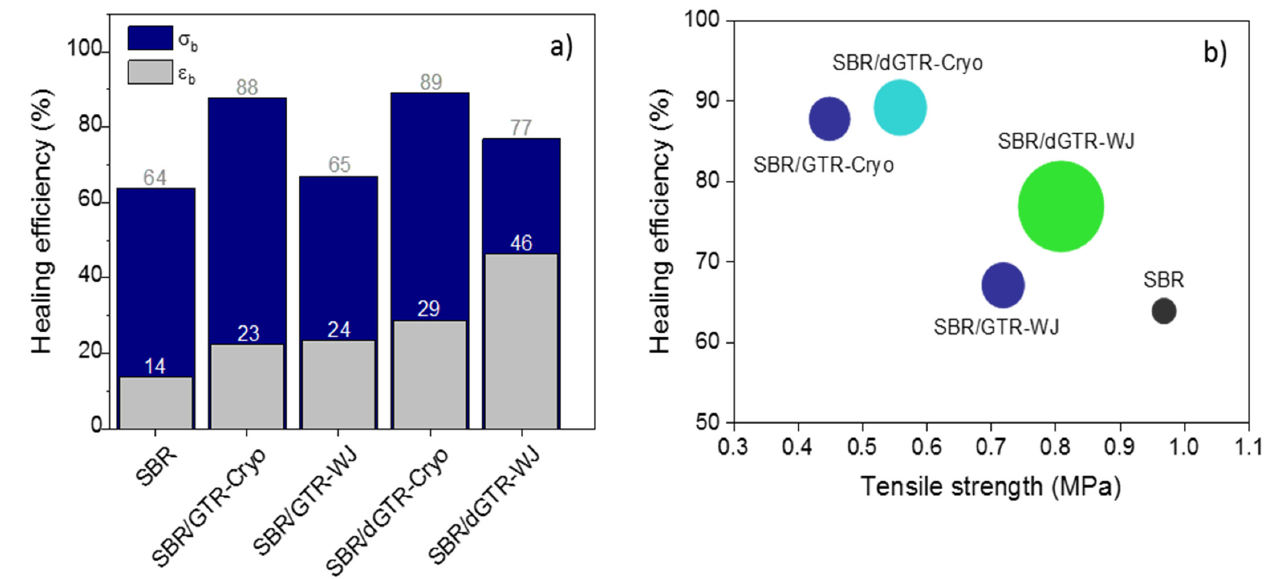
Figure 7. ( a ) Healing efficiency of SBR compounds with 30 phr of GTR/dGTR. ( b ) Overall healing performance of SBR compounds. The symbol size is properly scaled according to the recovery of the maximum strain.